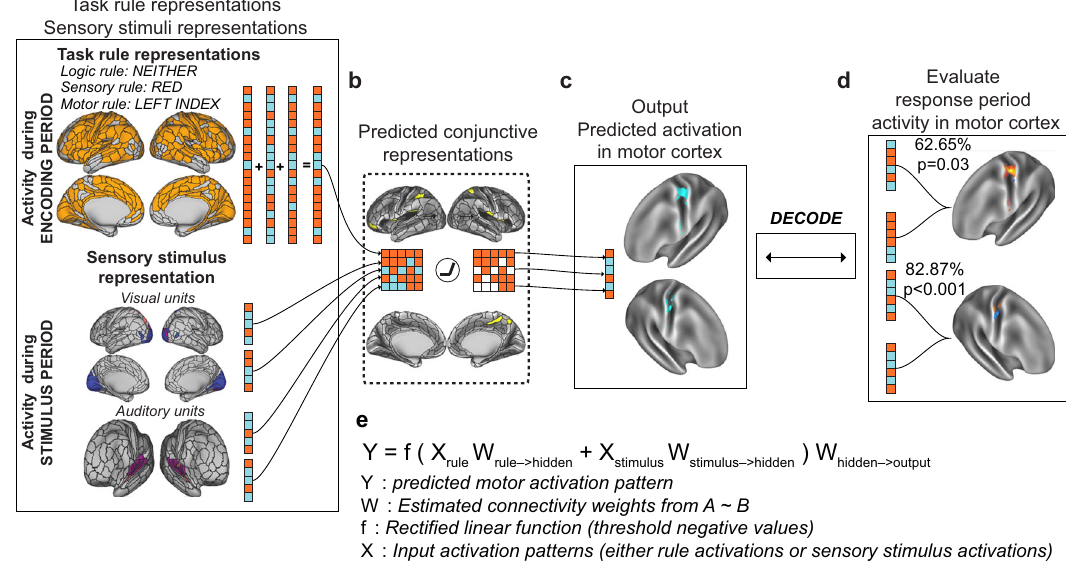
Fig. 6 Simulating context-dependent sensorimotor transformations with empirically-estimated task activations and inter-unit FC estimates. We constructed the ENN by identifying the vertices that contained task rule, sensory stimulus, and motor response activations and by estimating the resting- state FC weights between them. a The input layer, consisting of vertices with decodable task rule and sensory stimulus activations. b Through activity fl ow mapping, input activations were mapped onto surface vertices in conjunction hubs. The activity fl ow-mapped vertices were passed through a nonlinearity, which removed any negative values. This threshold was chosen given the dif fi culty in interpreting predicted negative BOLD values. c The predicted conjunctive activations were then activity fl ow-mapped onto the motor output vertices, generating a predicted motor activation pattern. d These predicted motor activations were then tested against the actual motor response activations of other subjects using a four-fold cross-validation scheme. A decoder was trained on the predicted motor response activations and tested on the actual motor response activations of the held-out cohort (see Methods and Supplementary Fig. 1). e An equation summarizing the ENN model ’ s